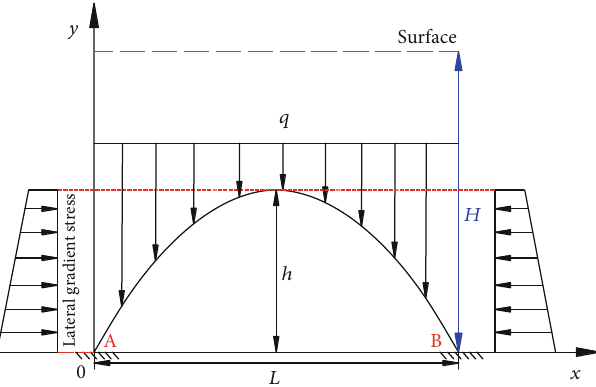
Figure 6: Mechanical model of the top-coal arch